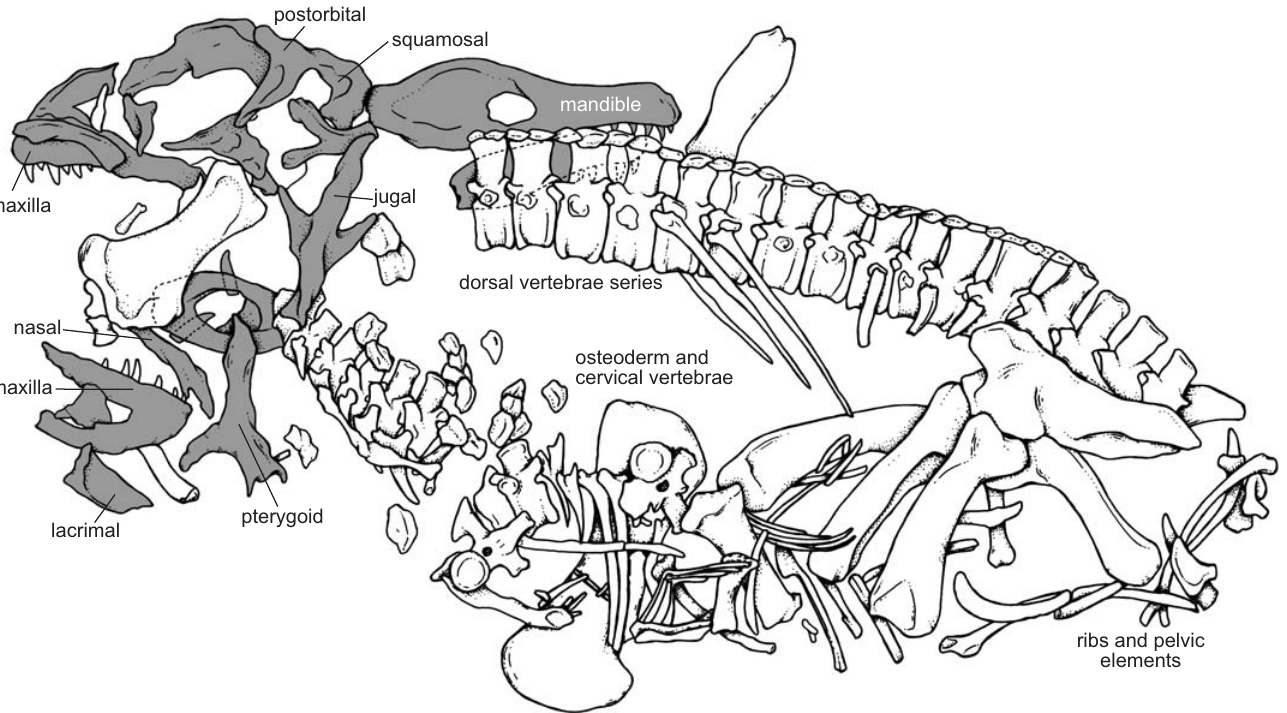
Fig. 3. Schematic drawing of the pseudosuchian archosaur Prestosuchus chiniquensis Huene, 1938 (UFRGS-PV-0629-T) from the Dinodontosaurus Assemblage Zone, Ladinian, Middle Triassic, Dona Francisca municipality, Rio Grande do Sul State, Brazil (drawing by Téo Veiga de Oliveira). Cranial elements in